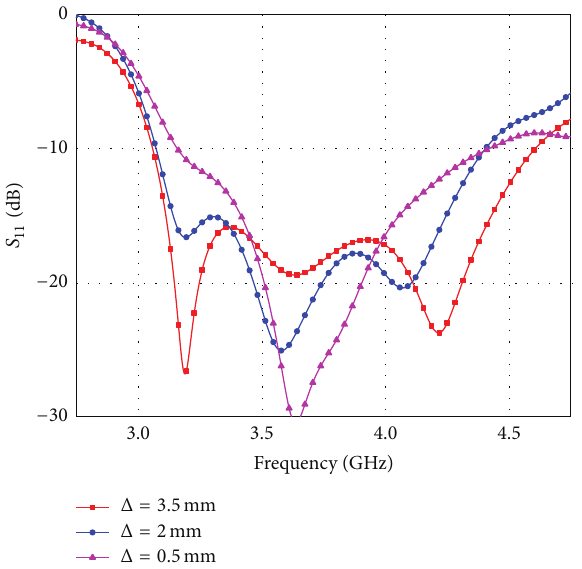
Figure 2: Effect of parameter Δ on antenna |𝑆 11 | .